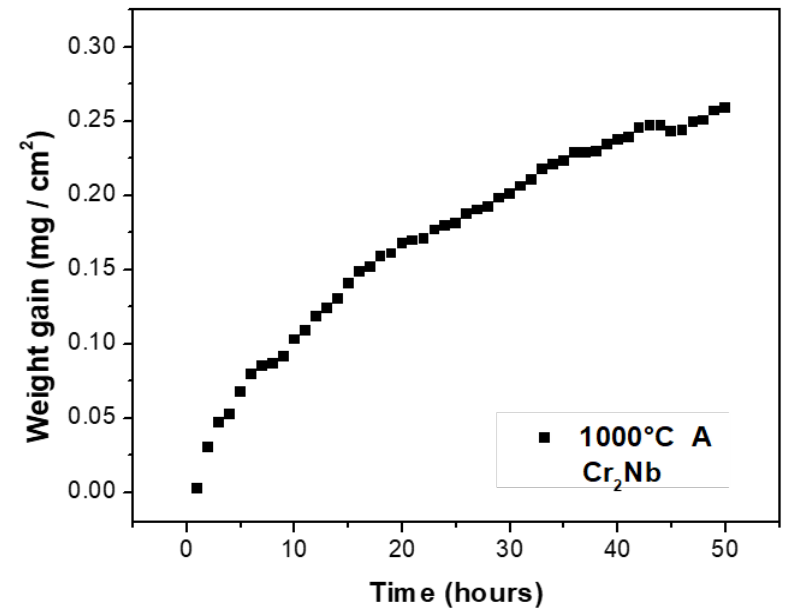
Figure 5. Weight gain and time relationship analyzed at 1000 °C.